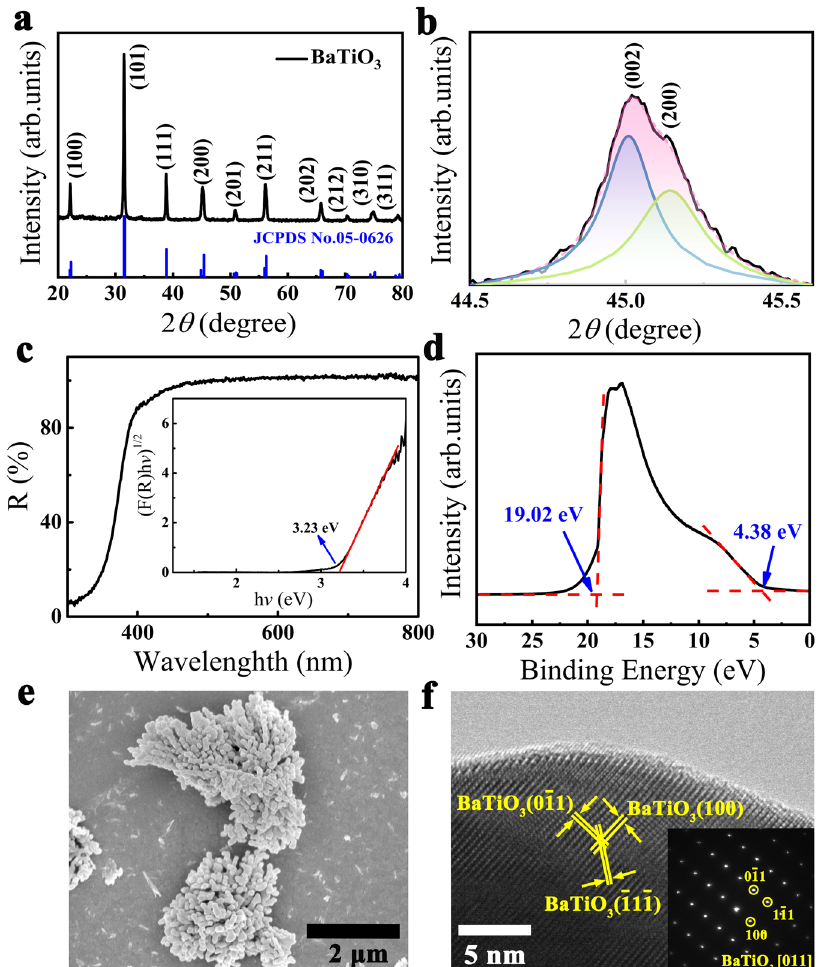
Fig.1|Characterizationsofas-preparedBaTiO 3 NPs.a XRDspectra. b Enlarged(002)and(200)XRDpeaks. c UV-Visdiffusere fl ectancespectrawithTauc ’ splotasinset. d UPS. e SEM image. f HRTEM image. The inset in ( f ) is the SAED pattern along [011] zone axis. Source data are provided as a Source Data fi